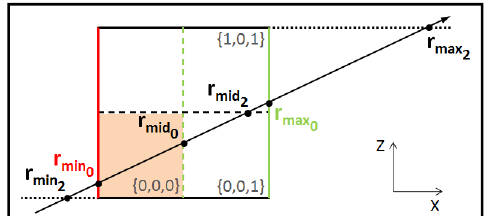
Figure 8. Example of a voxel intersection with first intersected sub-node (filled), entry plane (red) and exit planes (green): ray crosses sub-nodes 0 → 1 →